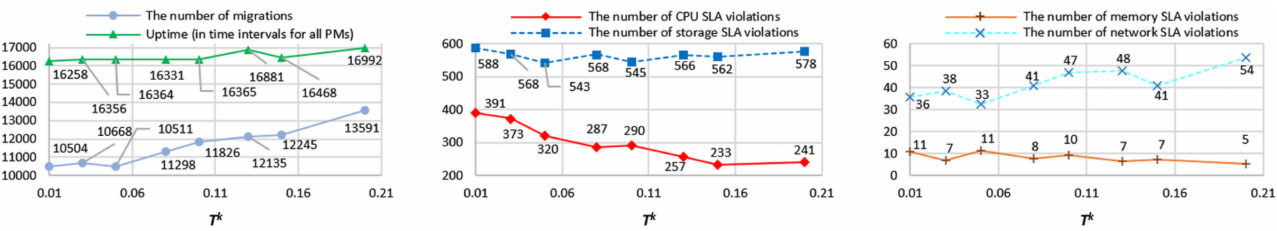
Figure 9. The effect of T k on the quality metrics for SLA violation minimization.